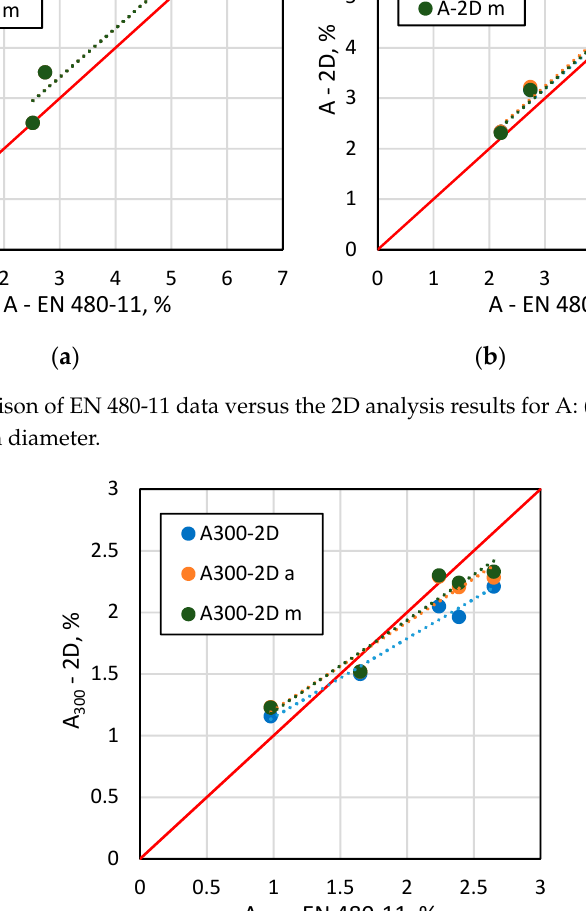
Figure 9. A comparison of EN 480-11 data versus the 2D analysis results for A 300 .